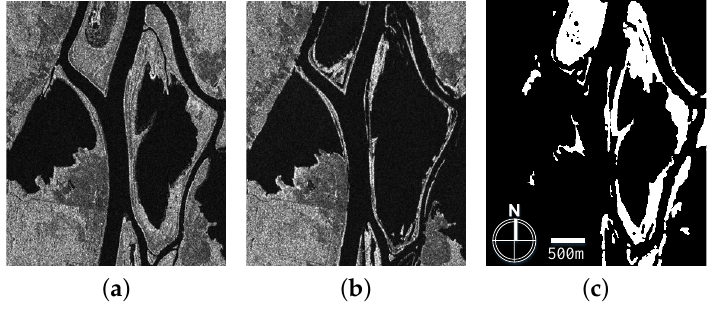
Figure 9. The Ottawa dataset: ( a ) the SAR image acquired in July 1997, ( b ) the SAR image acquired in August 1997, and ( c ) the reference